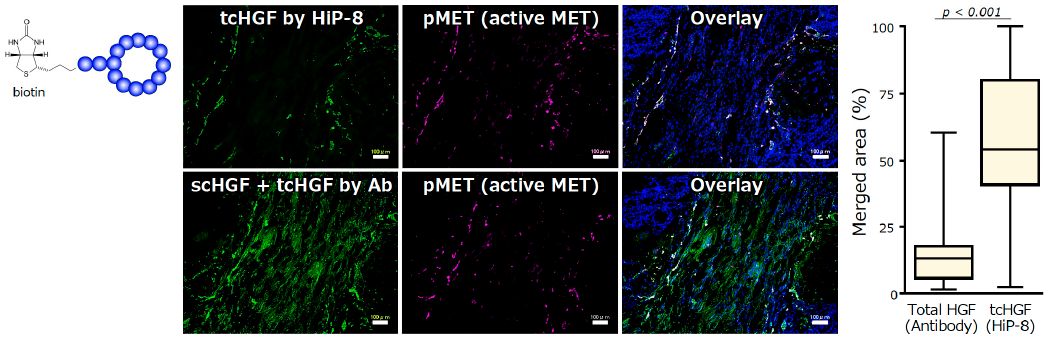
Figure 5. Detection of tcHGF by HiP-8, and the colocalization of HiP-8 probed tcHGF and pMET [20]. Scale bar, 100 μ m.